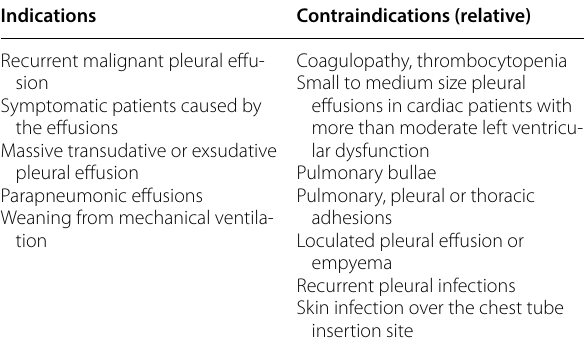
Table 1 Indications and contraindications to pleural drainage positioning